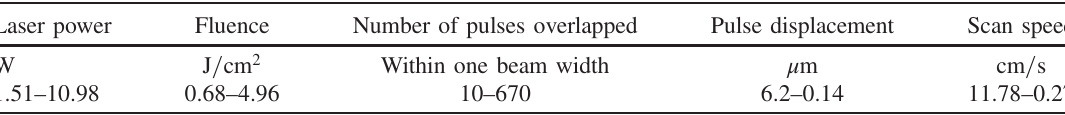
TABLE I. Laser irradiation parameters. Laser power